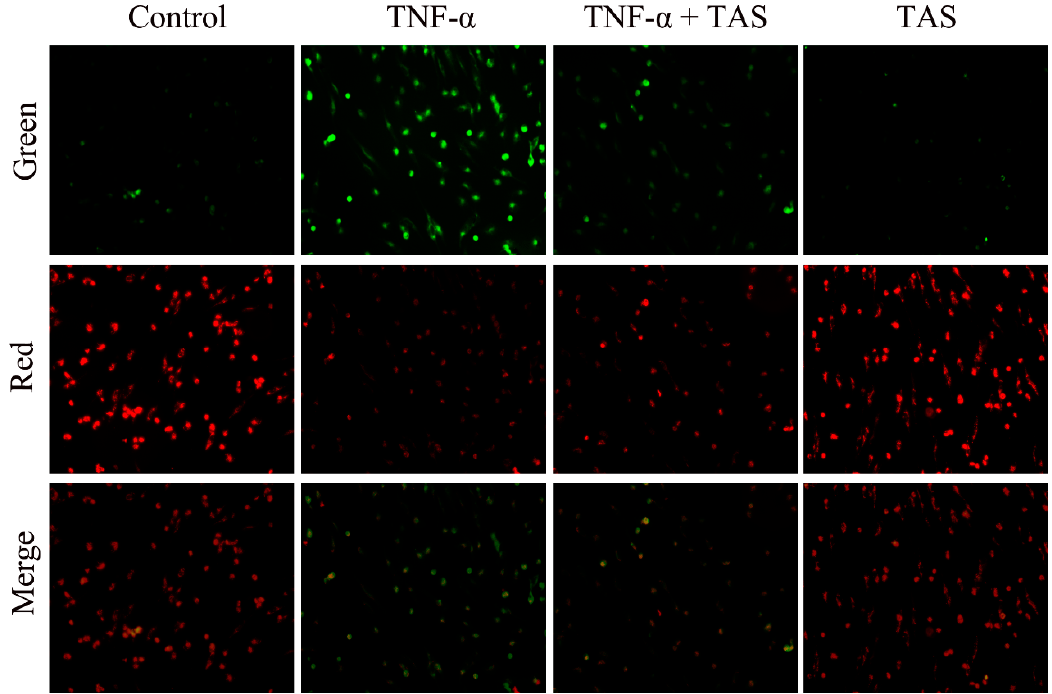
Figure 2. TAS restored mitochondrial transmembrane potential. HUVECs were preincubated with TAS (5 μ g/mL) for 2 h, followed by treatment with TNF- α (50 ng/mL) for 24 h. Mitochondrial membrane potential was determined with JC-1 staining, which was observed using a fluorescence microscope. Image of fluorescence microscope on mitochondrial membrane potential (MMP) was obtained with 200 X of magnification.